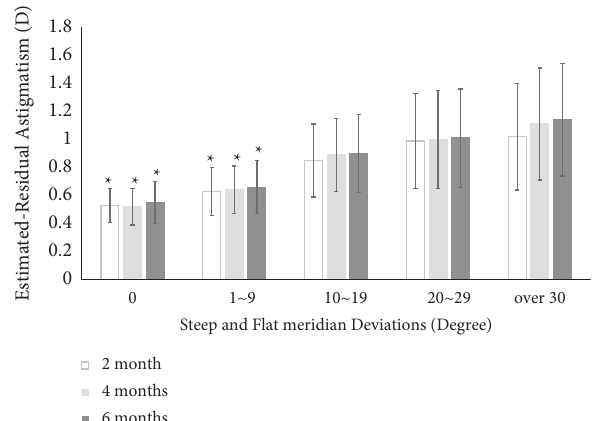
Figure 4: Postoperative estimated residual astigmatism according to steep and flat meridian deviations. Values are presented as mean ± SD. D, diopter. Estimated-residual astigmatism D values of 0 (0.53 ± 0.12) and 1–9 ° groups (0.63 ± 0.17) were significantly lower than those of 10–19 (0.85 ± 0.26), 20–29 (0.99 ± 0.34), and over 40 ° groups (1.02 ± 0.38) in steep and flat meridian deviations at postoperative 2, 4, and 6 months ( P < 0 . 05).